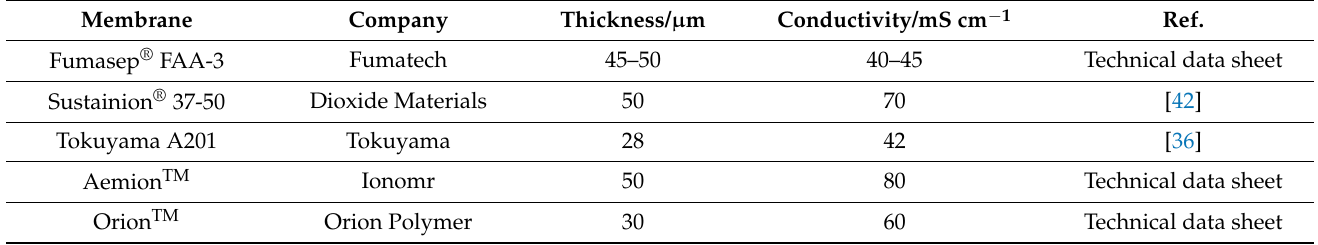
Table 1. Main characteristics of the most commonly used commercial